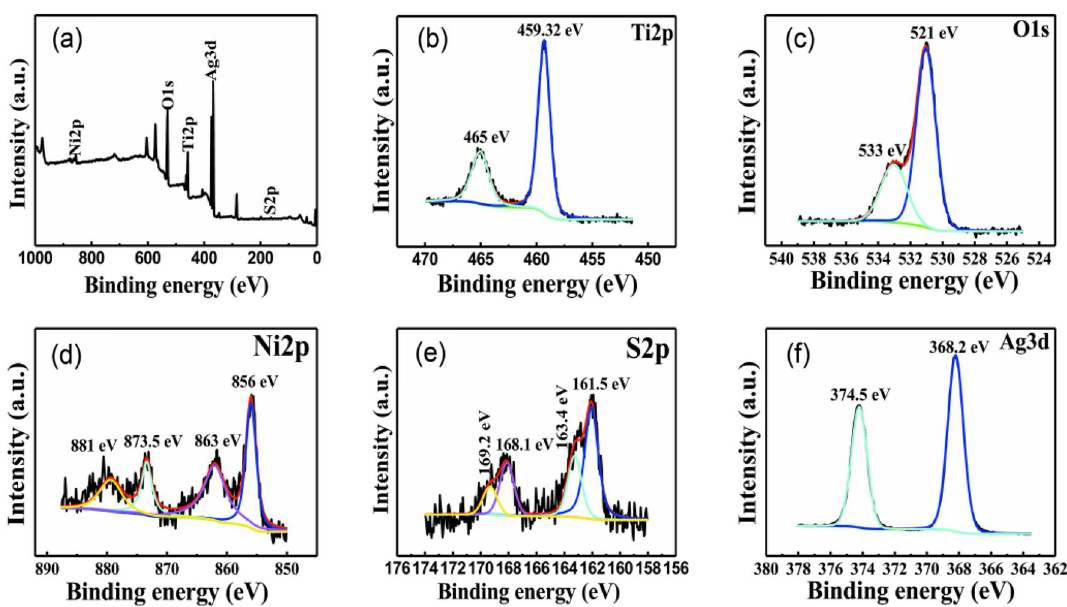
Figure 9. XPS survey spectra of Ag/NiS/TiO 2 ( a ) and high-resolution Ti 2p ( b ), O 1 s ( c ), Ni 2p ( d ), S 2p ( e ) and Ag 3d ( f ) XPS